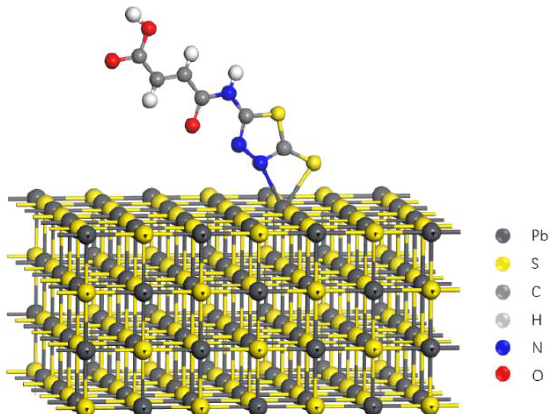
Figure 13. The potential adsorption mechanism mode of MATT on galena surface.